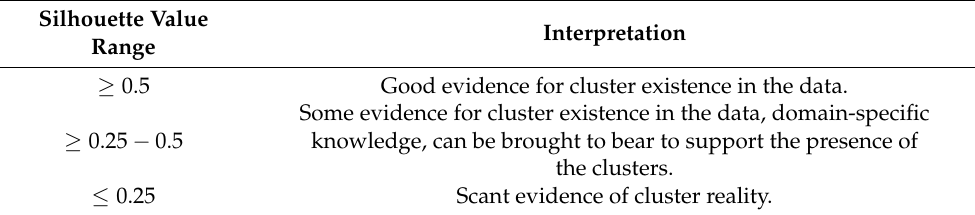
Table 2. Silhouette score interpretation